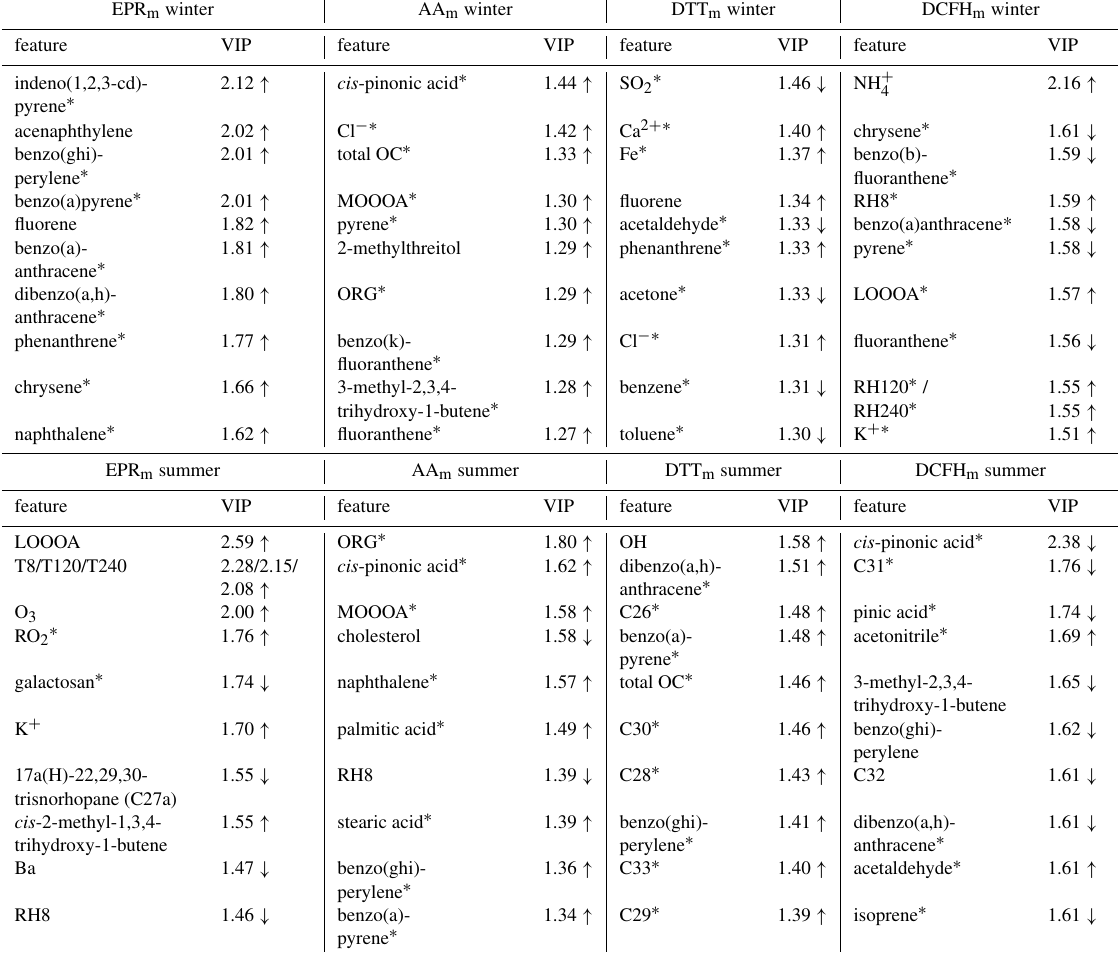
Table 3. Characteristic loadings most influential in PLSR models of OP m as defined by ordered variable importance in projection for each model. Upward arrows indicate positive correlation with the assay measurement, downward arrows for inverse correlation and ∗ for p < 0.05 in Spearman correlation of the feature with the assay in the univariate